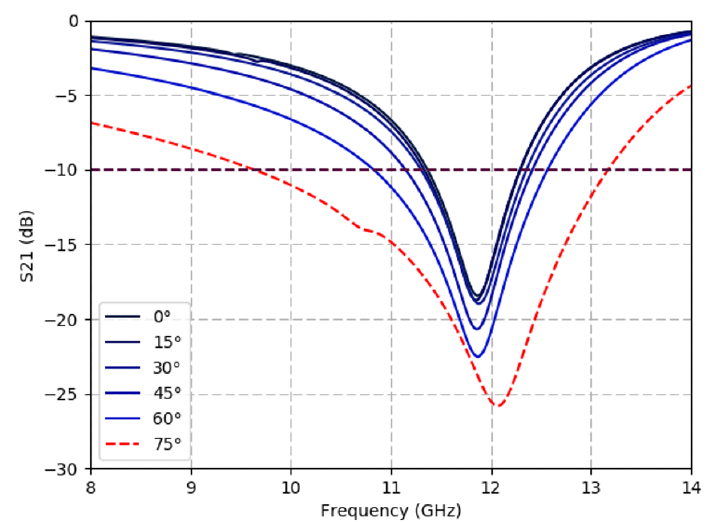
Figure 4. Spiral-based FSS specificity diminishes at large angles of incidence. Simulated S 21 response of a triangular lattice varying oblique incidence values, θ = 0°,15°,30°,45°,60°,75°, with constant φ = 0° and in the flat state ( β = 0°)